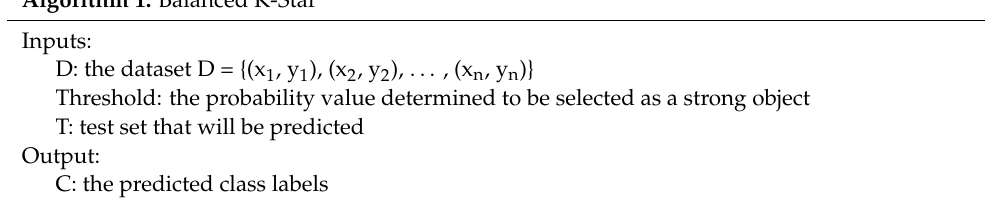
Algorithm 1. Balanced K-Star